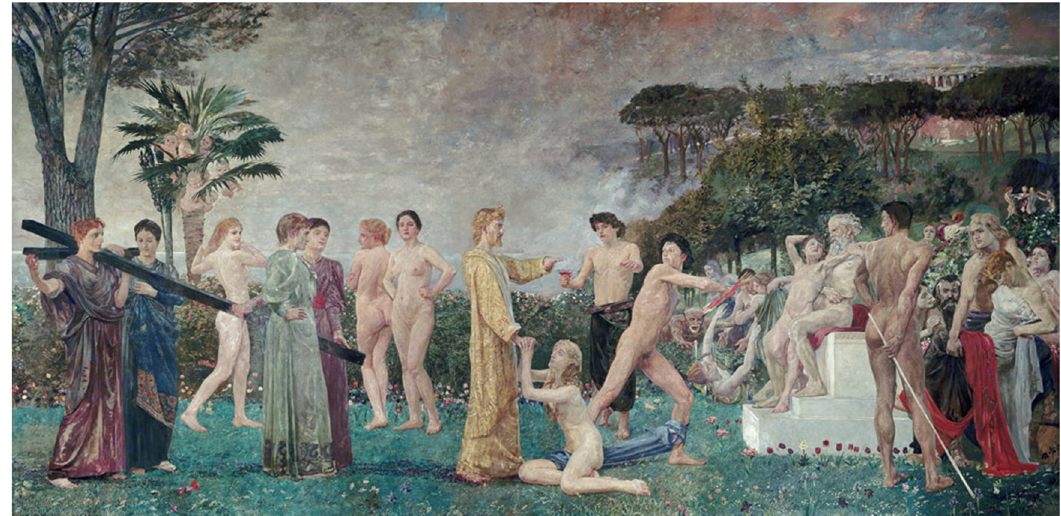
Figure 35: Max Klinger, Christus im Olymp ( 1890 – 1897 ) . Destroyed, WWII. Public Domain. Museum of Fine Arts,